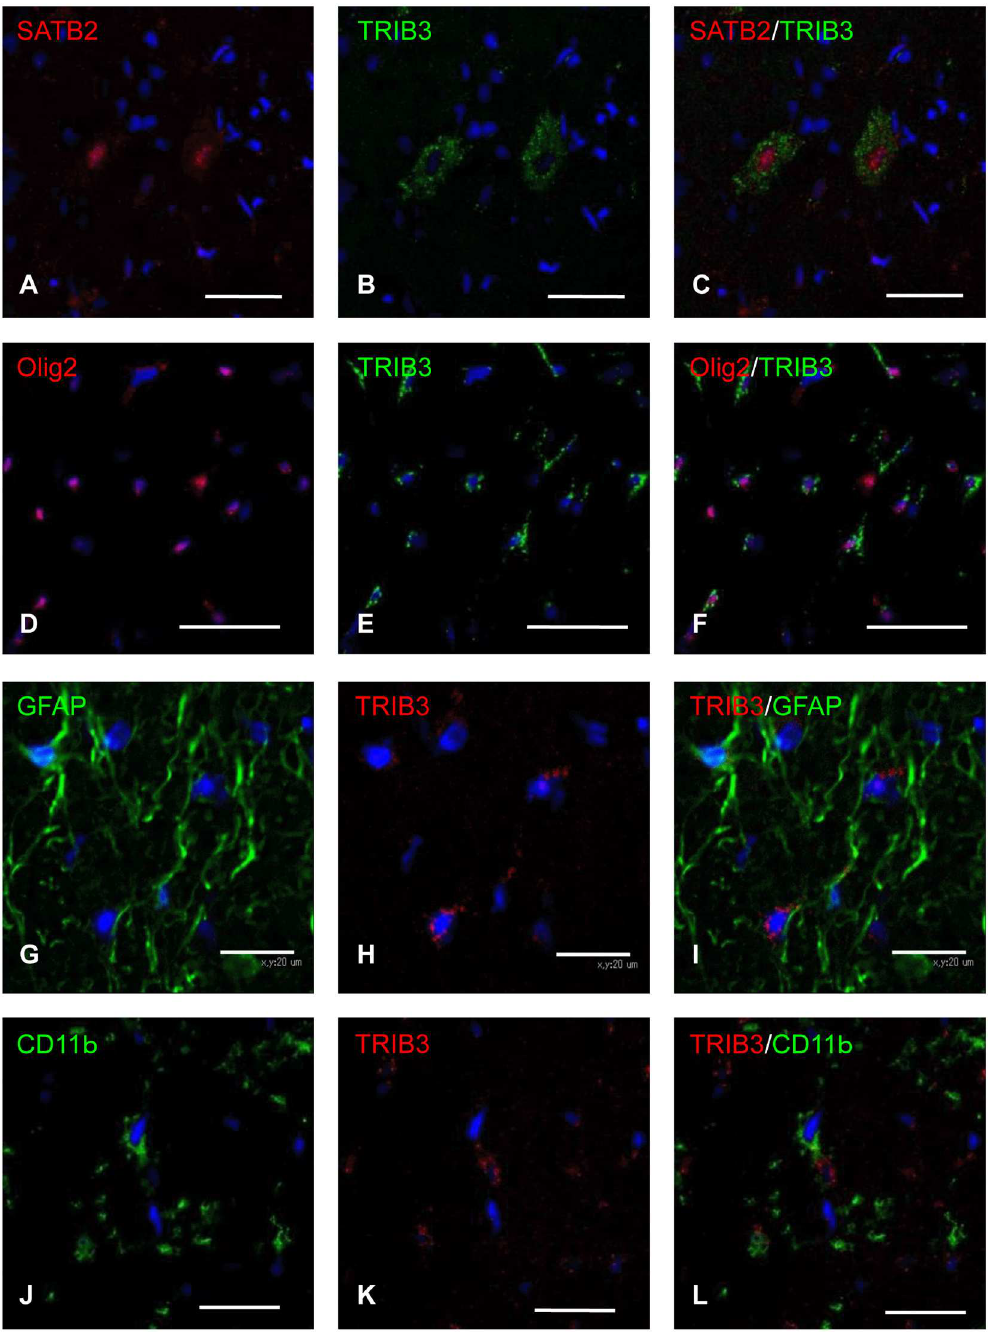
Fig 4. Double immunofluorescence for SATB2, Olig2, GFAP, CD11b and TRIB3. The double immunohistochemistry for SATB2 (A-C), Olig2 (D-F), GFAP (G-I), CD11b (J-L) and TRIB3 in the lumbar spinal cords from the dmy rats at 7-week-old.SATB2-positive neuronsand Olig2-positive oligodendrocytes are positive for TRIB3, althoughGFAP-positive astrocytes and CD11b-positive microglialcells are not positive for TRIB3. Bars: A-F, J-L; 20 μ m, G-I; 50 μ